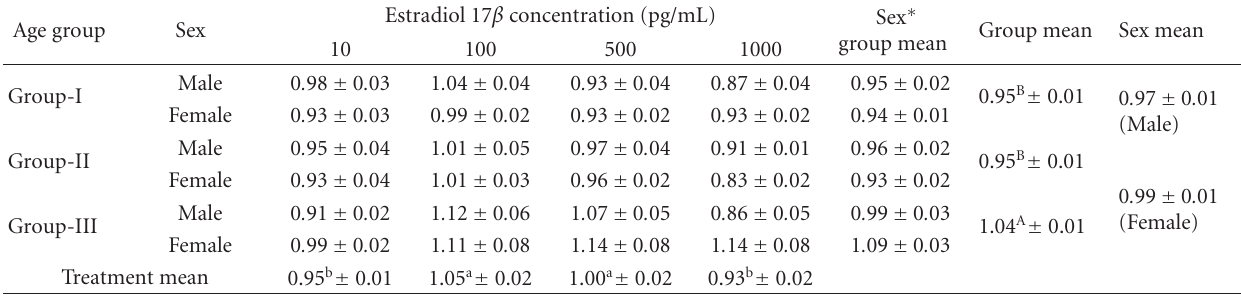
Table 1: Dose-dependent e ff ect of estradiol 17 β on lymphocyte proliferation in vitro in Murrah bu ff aloes of di ff erent sex and age. Age